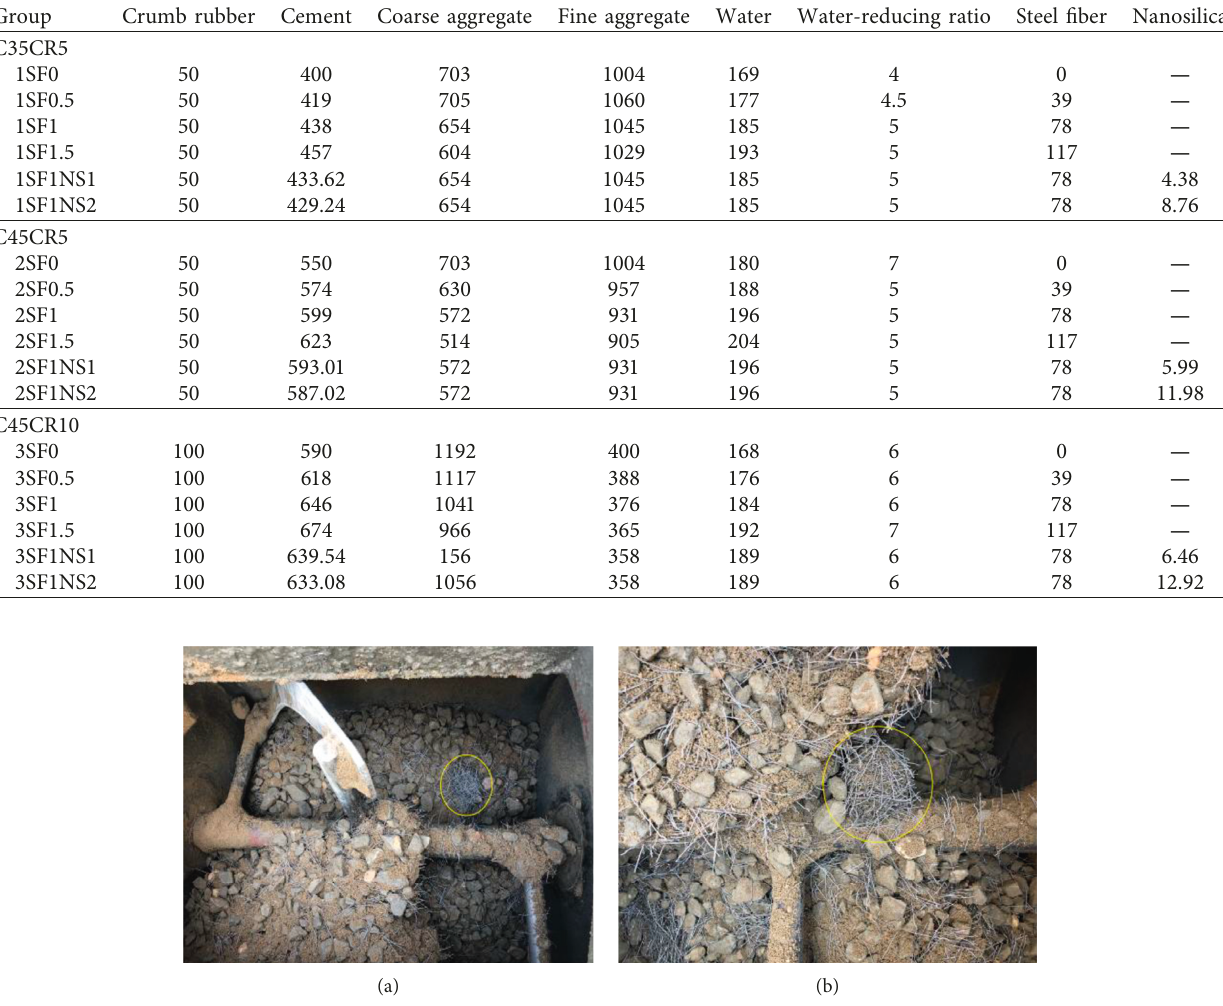
Figure 1: The (a) crumb rubbers, (b) steel fibers, and (c) nanosilica used in this test. Table 1: Concrete mixture proportion (unit: kg/m 3 ).